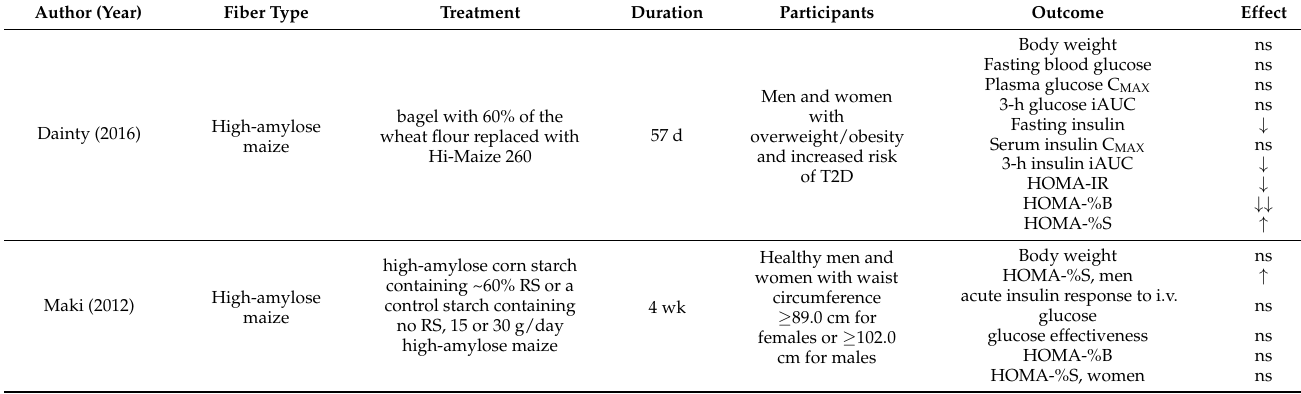
Table 2. Summary of human fiber research with outcomes involving energy homeostasis, glucose homeostasis, lipid metabolism, and/or inflammation. Downward pointing arrow indicates significant decrease in outcome in intervention group (compared to control or baseline); upward pointing arrow indicates significant increase in outcome in intervention group (compared to control or